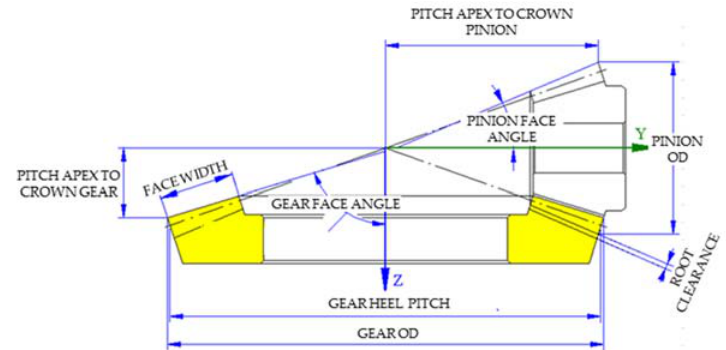
Figure 1. Spiral Bevel gear parameters.